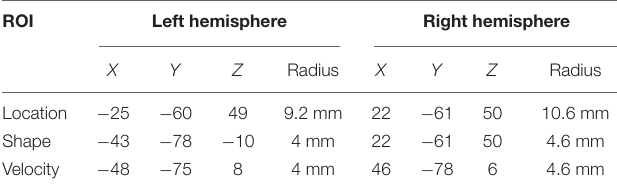
TABLE 3 | MNI coordinates of the center of regions of interest in the left and right hemispheres and radii in millimeters.